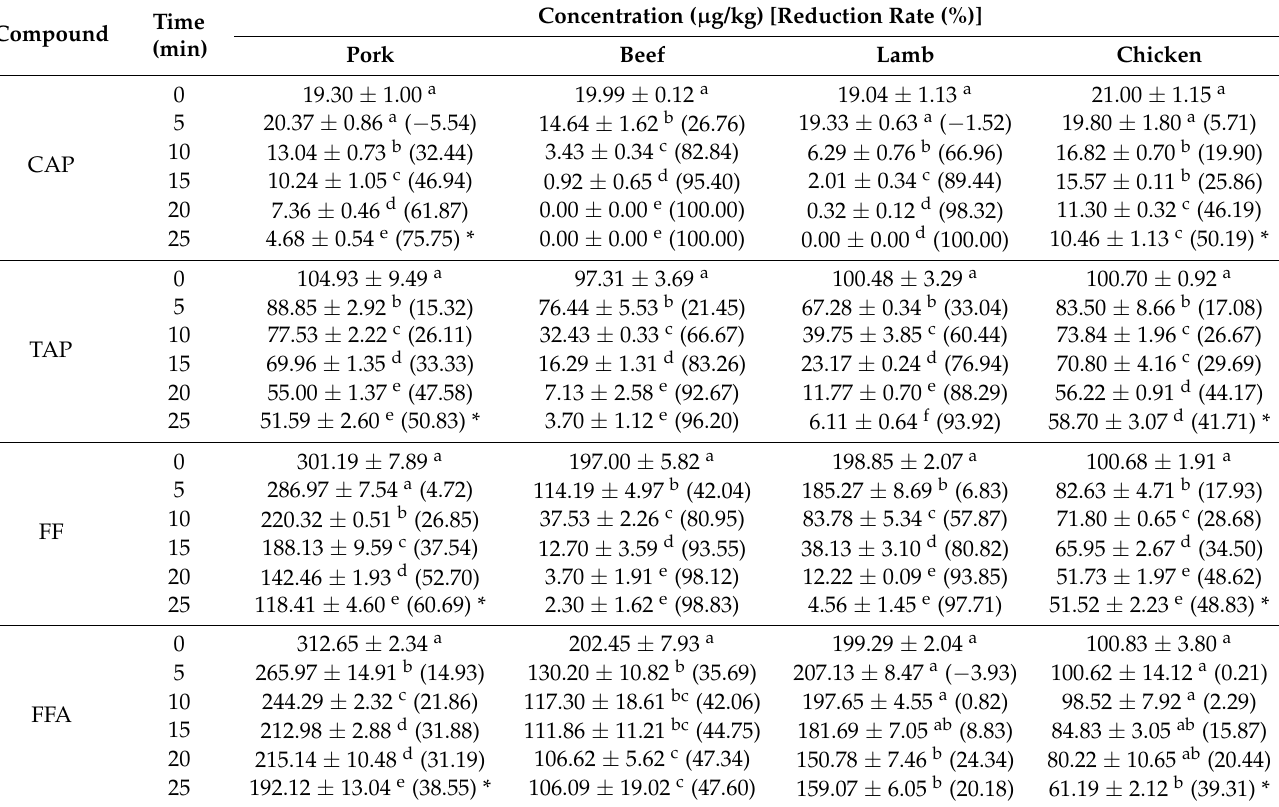
Table 5. Effect of boiling time on residues of amphenicols and metabolites in livestock and poul- try